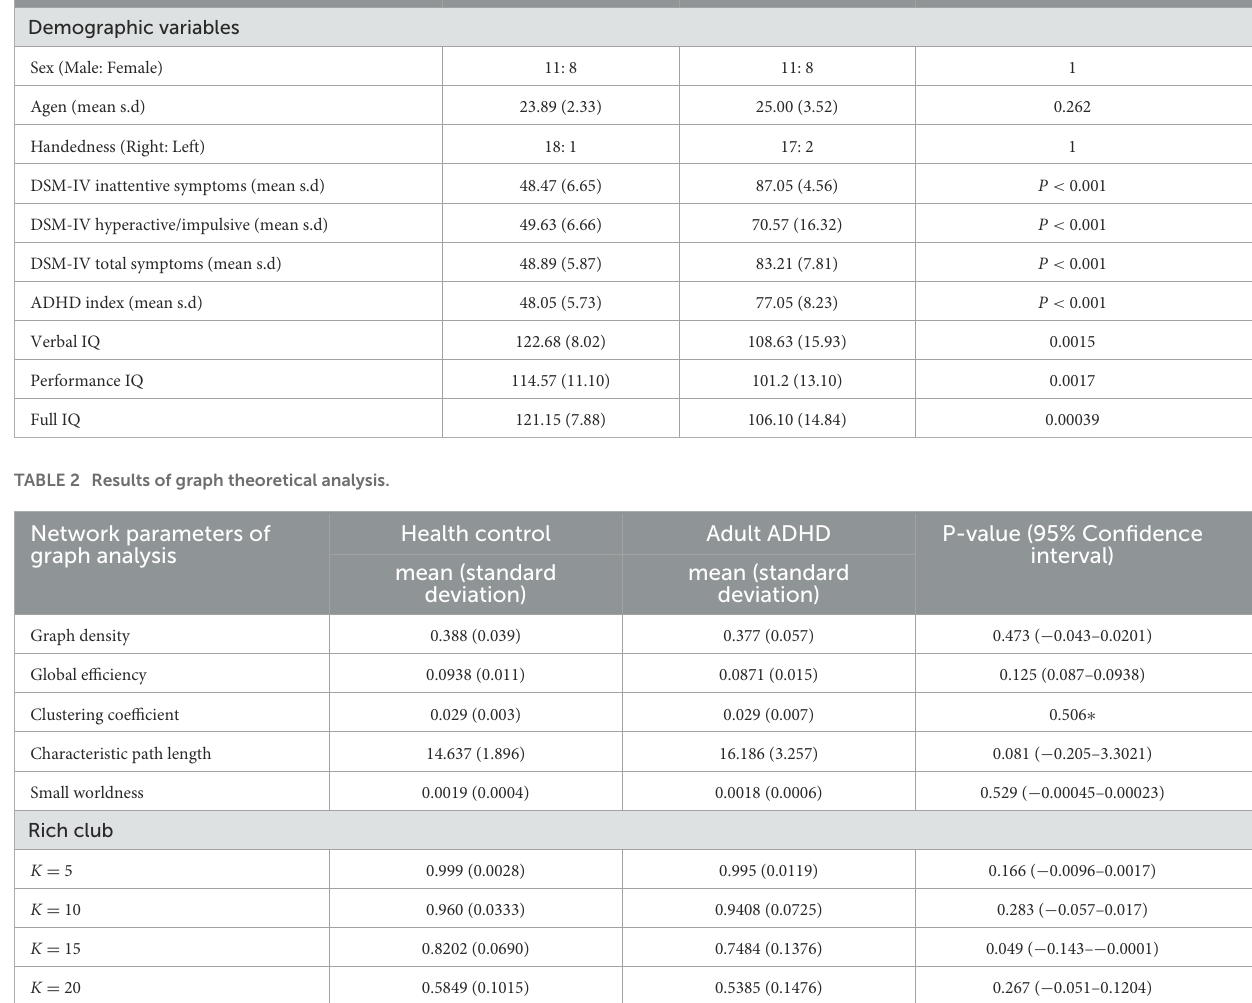
Chi-square test)